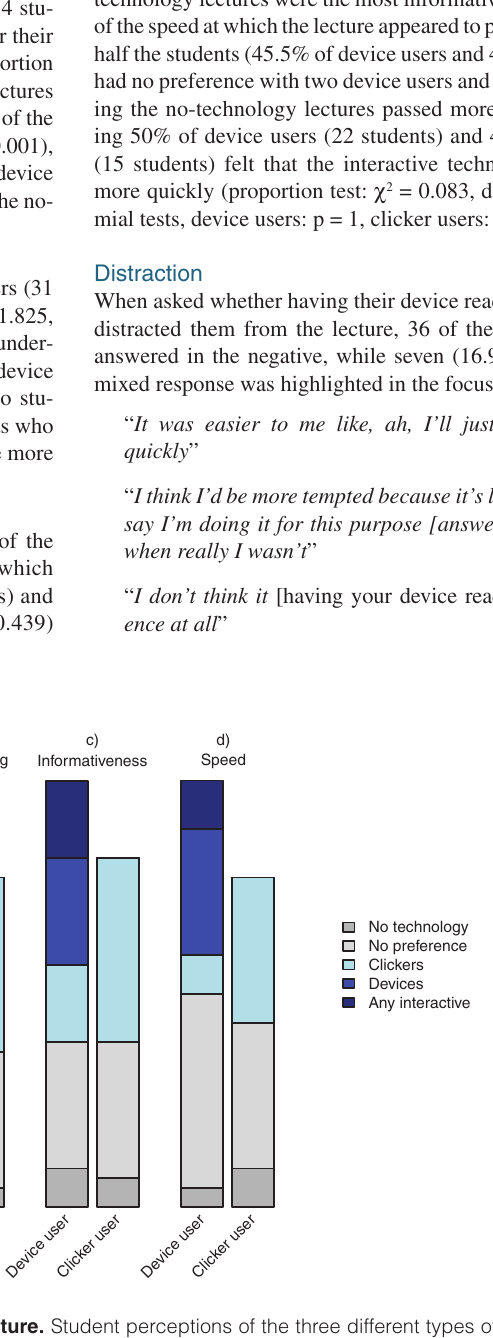
Figure 1. Student perceptions of the different types of lecture. Student perceptions of the three different types of lecture (no interactive technology, clicker and personal devices as response systems), in terms of their a) Enjoyment, b) Understanding, c) Informativeness and d) perception of the speed at which the lecture passes (fast = good), for students that used their own technology (device users) and those that used clickers (clicker